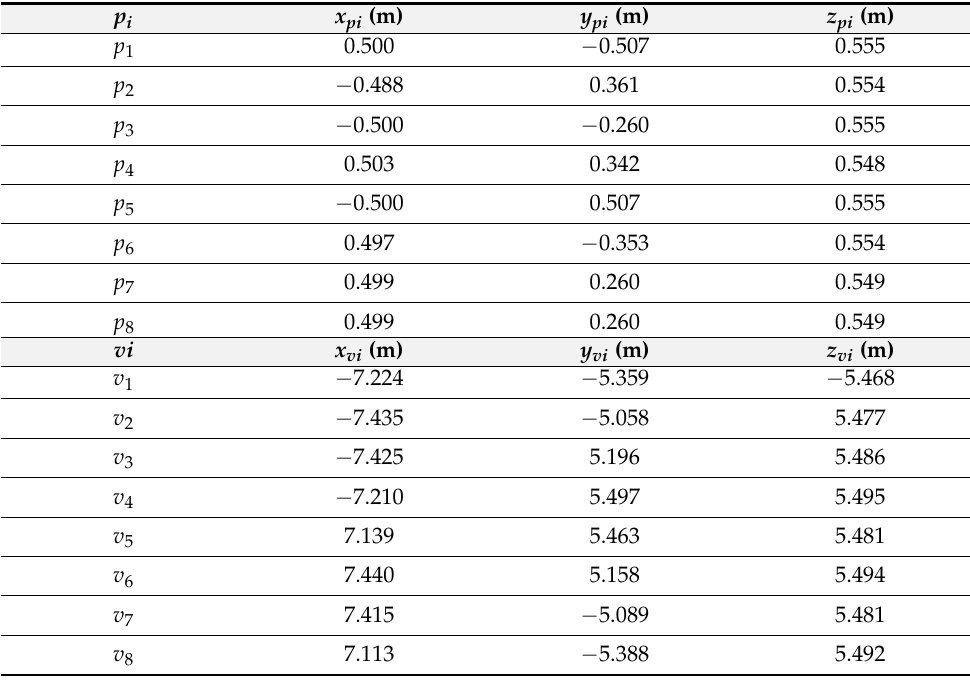
Figure 15. Angular accelerations of winches.